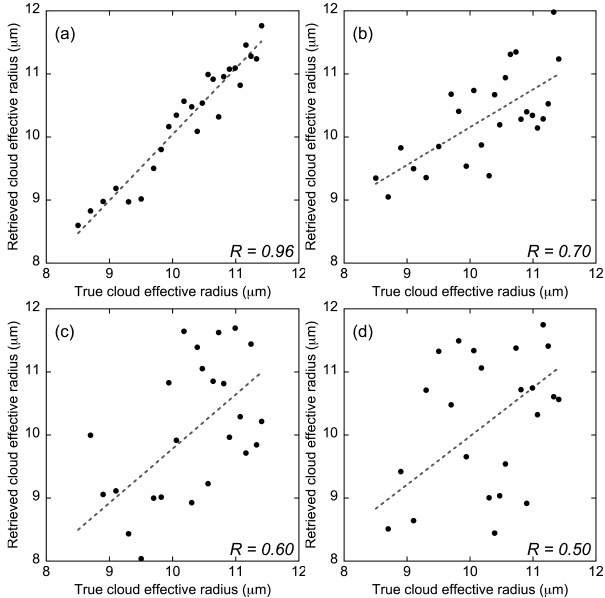
Fig. A1. Plots of the retrievals versus the truth, assuming that the retrievals agree to the truth within an error of (a) 0.5µm, (b) 1.0 µm, (c) 1.5µm, (d) 2.0µm. The corresponding correlation coeffi- cient ( R) is listed in each